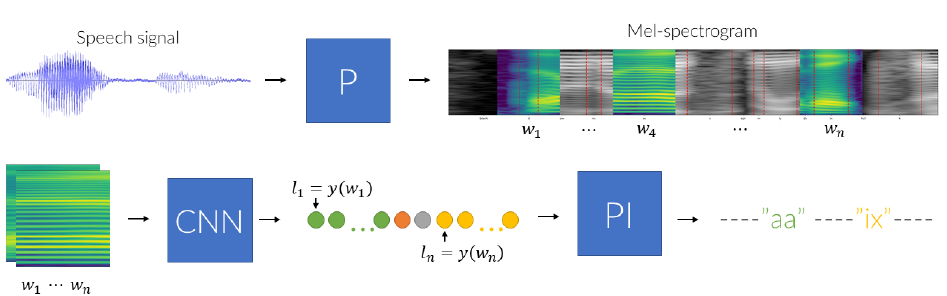
Figure 1. A diagram of the proposed utterance analysis method. The data preprocessing module (P) transforms input speech to Mel-Spectrogram windows (denoted by w i ), which are subsequently classified by a Convolutional Neural Network that assigns a label l i to each input window w i . The resulting sequence of predicted labels is analyzed by a phoneme identification module (PI), which produces a sequence of recognized